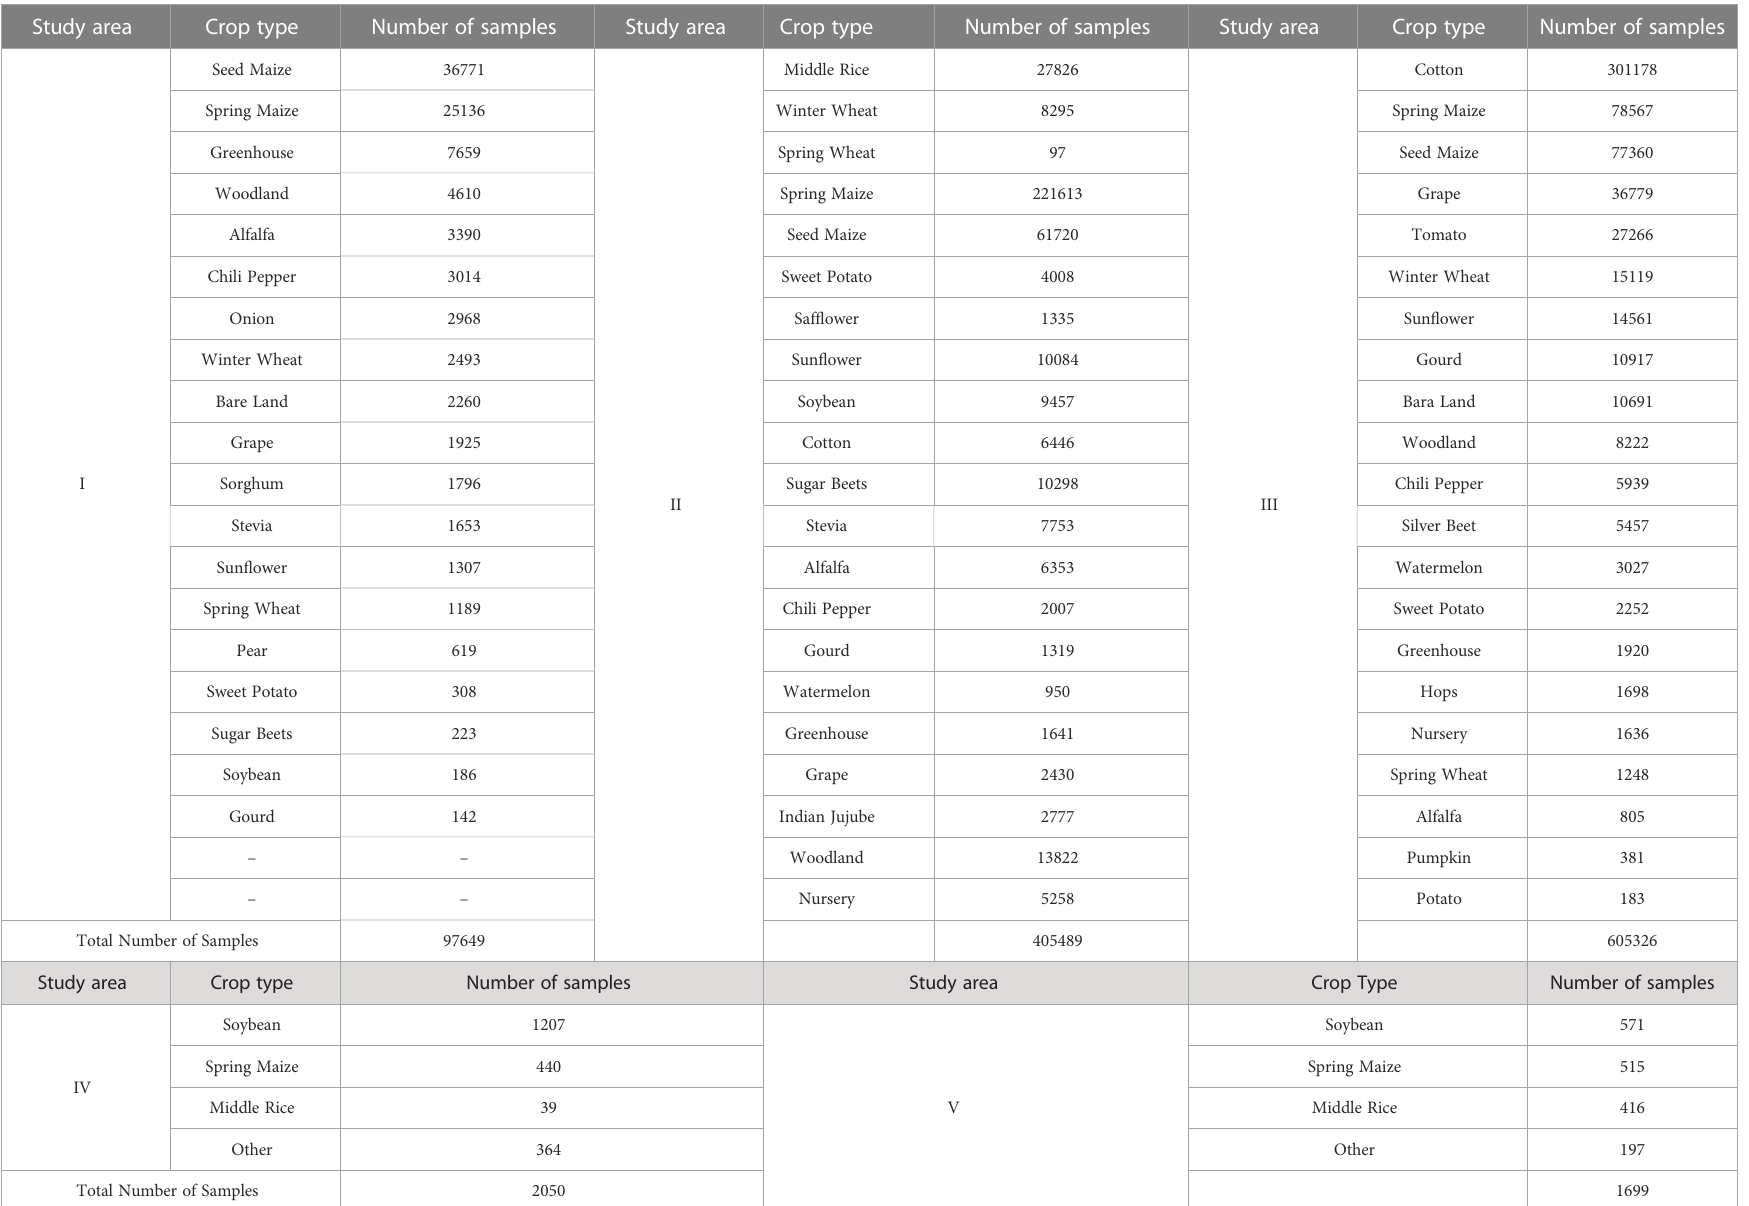
TABLE 2 Number of Samples in the Three Study